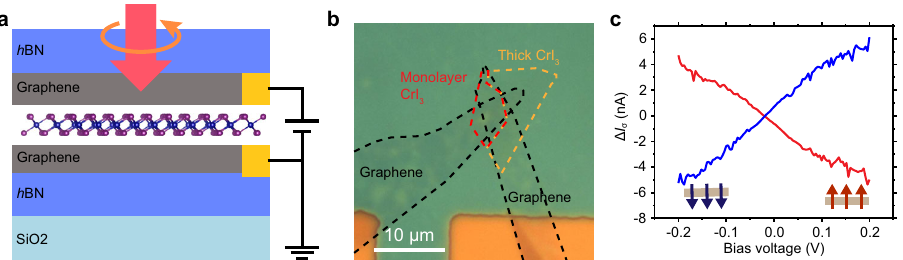
Fig. 1 The monolayer CrI 3 light helicity detector D1. Schematic diagram ( a ) and optical micrograph ( b ) of a monolayer CrI 3 (demarcated by the red dashed lines) light helicity detector D1 with few-layer graphene contacts (demarcated by the black dashed lines). The yellow dashed lines demarcate the thick CrI 3 , which was not illuminated by the excitation light in the measurements. The device is encapsulated by h BN fl akes. c The difference of the light-on currents ( Δ I σ = I + − I − ) under σ þ and σ (cid:2) excitations as function of the bias, measured at μ 0 H = 0 T. Before being measured, the monolayer CrI 3 device was fully magnetized at | μ 0 H | > 0.3 T. The red (blue) color denotes up (down) magnetized CrI 3 . The Δ I σ – V curve shows negative (positive) slope for up (down) magnetized state of monolayer CrI 3 . These results show that the photocurrents in a fully magnetized CrI 3 is helicity-dependent.